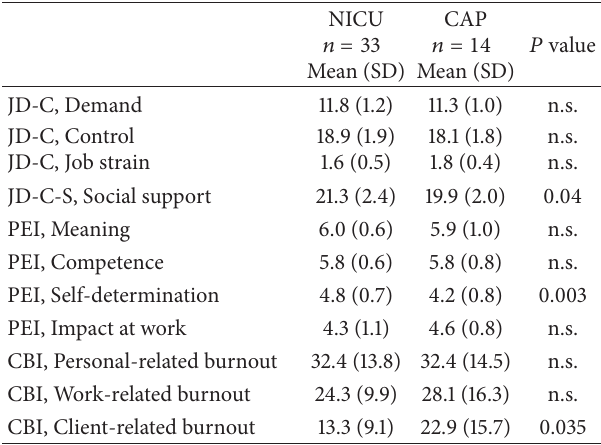
Table 2: Mean and standard deviations (SD) for the Job Demand- Control Model (JD-C and JD-C-S), the Psychological Empower- ment Instrument (PEI), and the Copenhagen Burnout Inventory (CBI) for nurses from the neonatal intensive care unit (NICU) and the child and adolescent psychiatry inpatient ward (CAP), respectively.